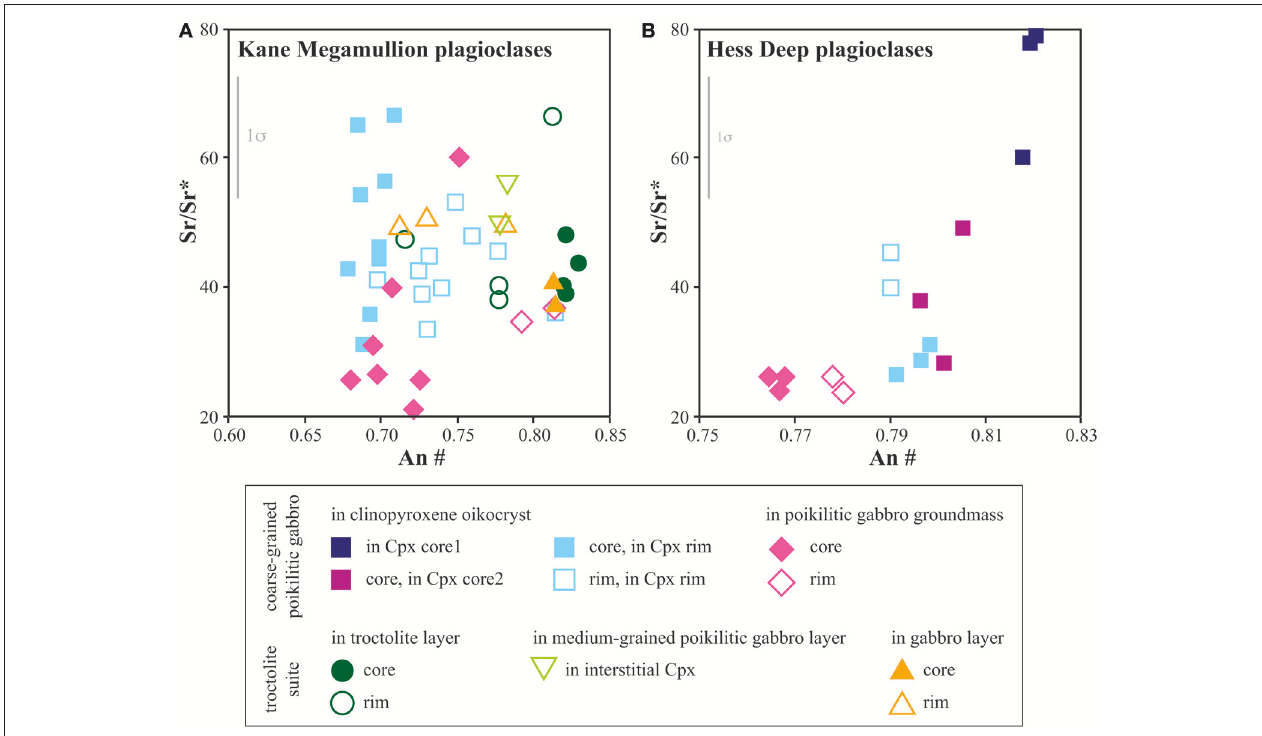
Figure 7 | Plagioclase Sr/Sr* vs. An composition in (A) Kane Megamullion poikilitic gabbro clinopyroxene and groundmass, and in troctolite, medium-grained poikilitic gabbro and gabbro layers and in (B) Hess Deep poikilitic gabbro clinopyroxene and groundmass. The anorthite content shows reverse zoning in poikilitic gabbros and normal zoning in troctolite, medium-grained poikilitic gabbro and gabbro layers. The groundmass Sr/Sr* is low.